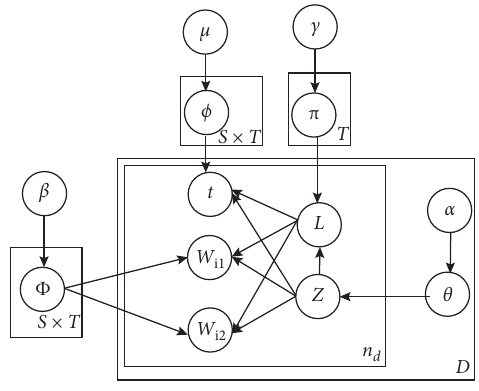
Figure 2: TSTS model.